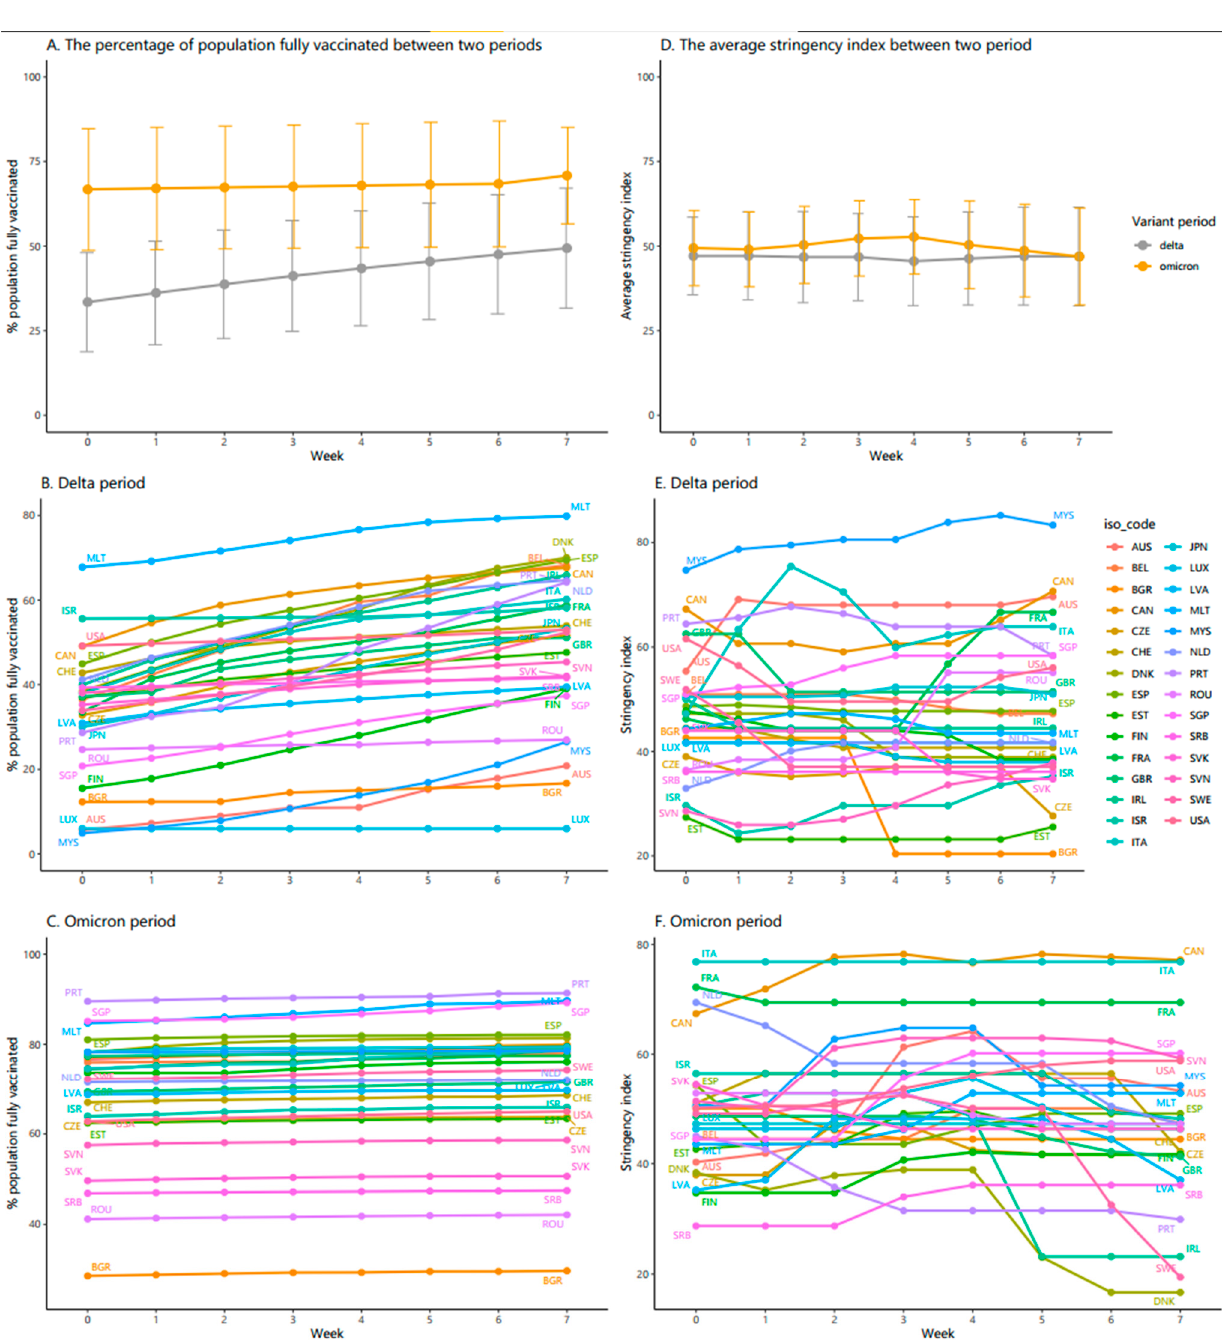
Figure 2. Government response and vaccination coverage across 29 countries over the first 8